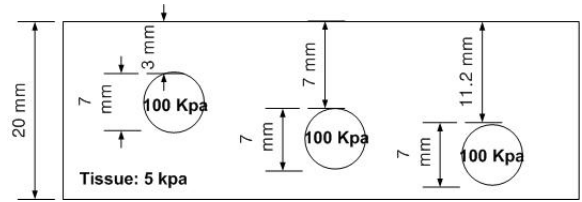
Figure 12. Tactile sensation images of three inclusions embedded in the depth phantom: